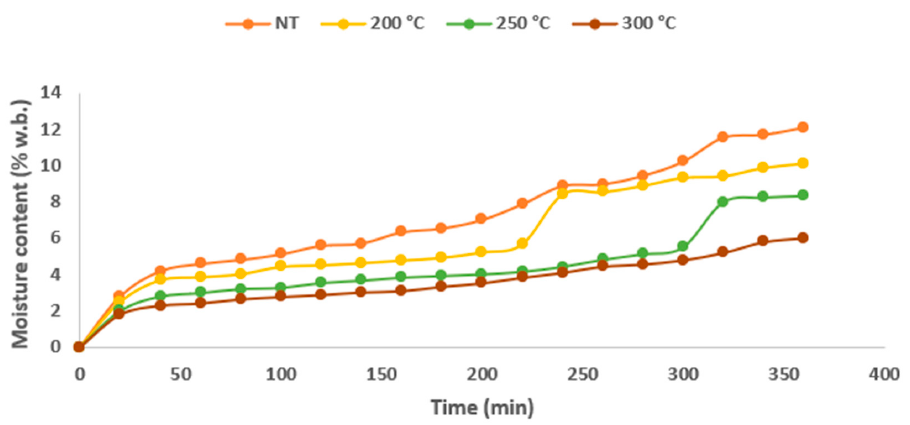
Figure 9. Moisture absorption of torrefied and non-torrefied WSS pellets.